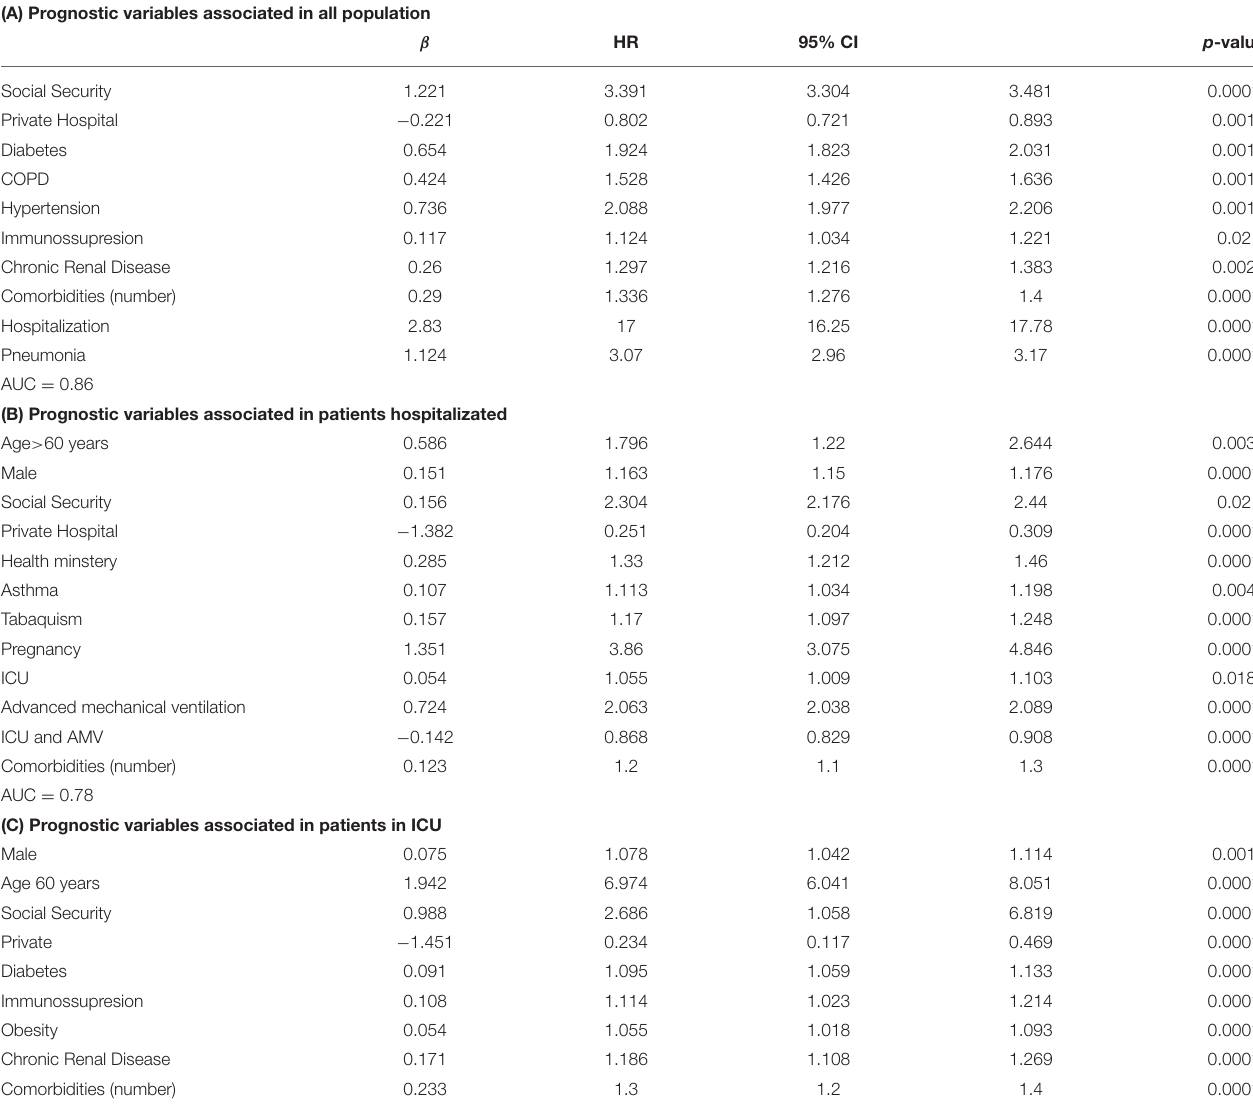
TABLE 5 | Proportional Cox Regression for prognostic mortality in patients with SARS CoV-2. (A) Prognostic variables associated in all